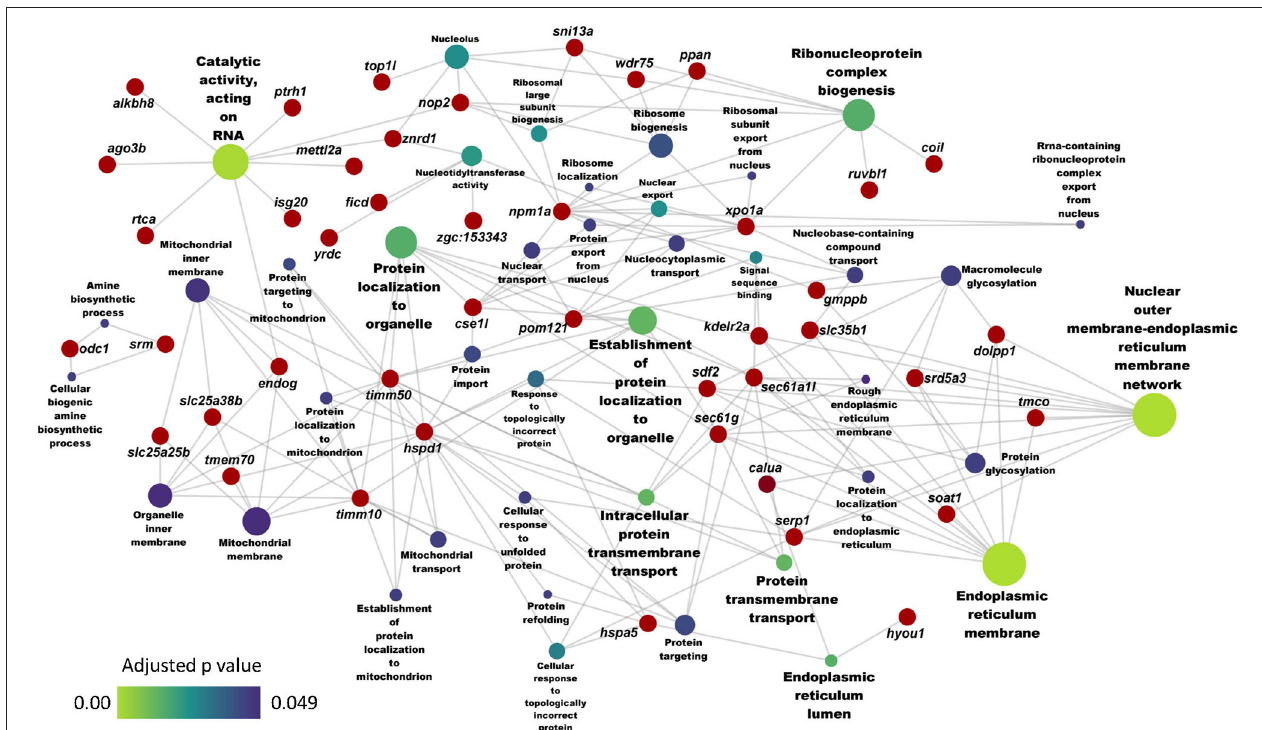
FIGURE 4 | Network showing the link between enriched GO terms and the associated genes that were upregulated in zebrafish fed the high cholesterol (HC) diet compared to the control (CT) diet. Genes that were considered for the enrichment are written near the red circles. The gradient color bar intensity varies with the